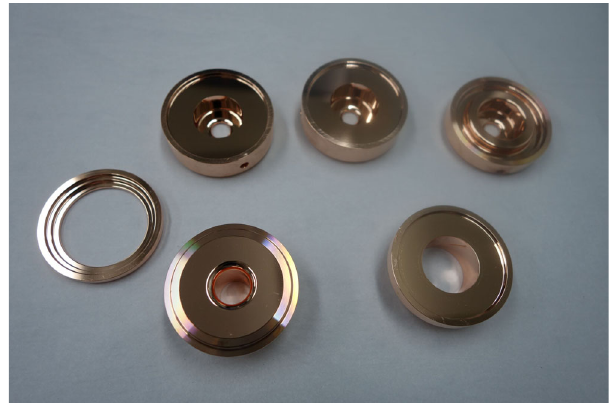
FIG. 7. Disks of choke-mode accelerating